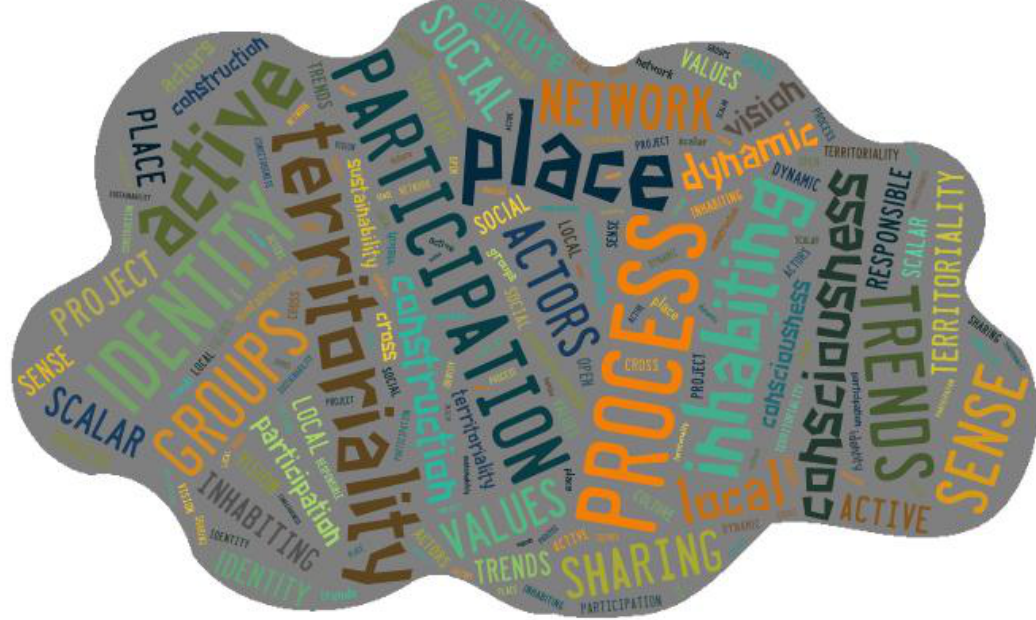
Figure 1: Tag cloud of local territorial identity in a French-Italian territorialist perspective (including the most frequent words used by the AGeI group “Territorial Identities” in the publications realised until